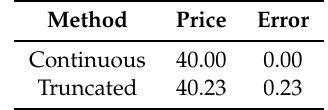
Table 4. Volatility swap replication under high volatility (40%).